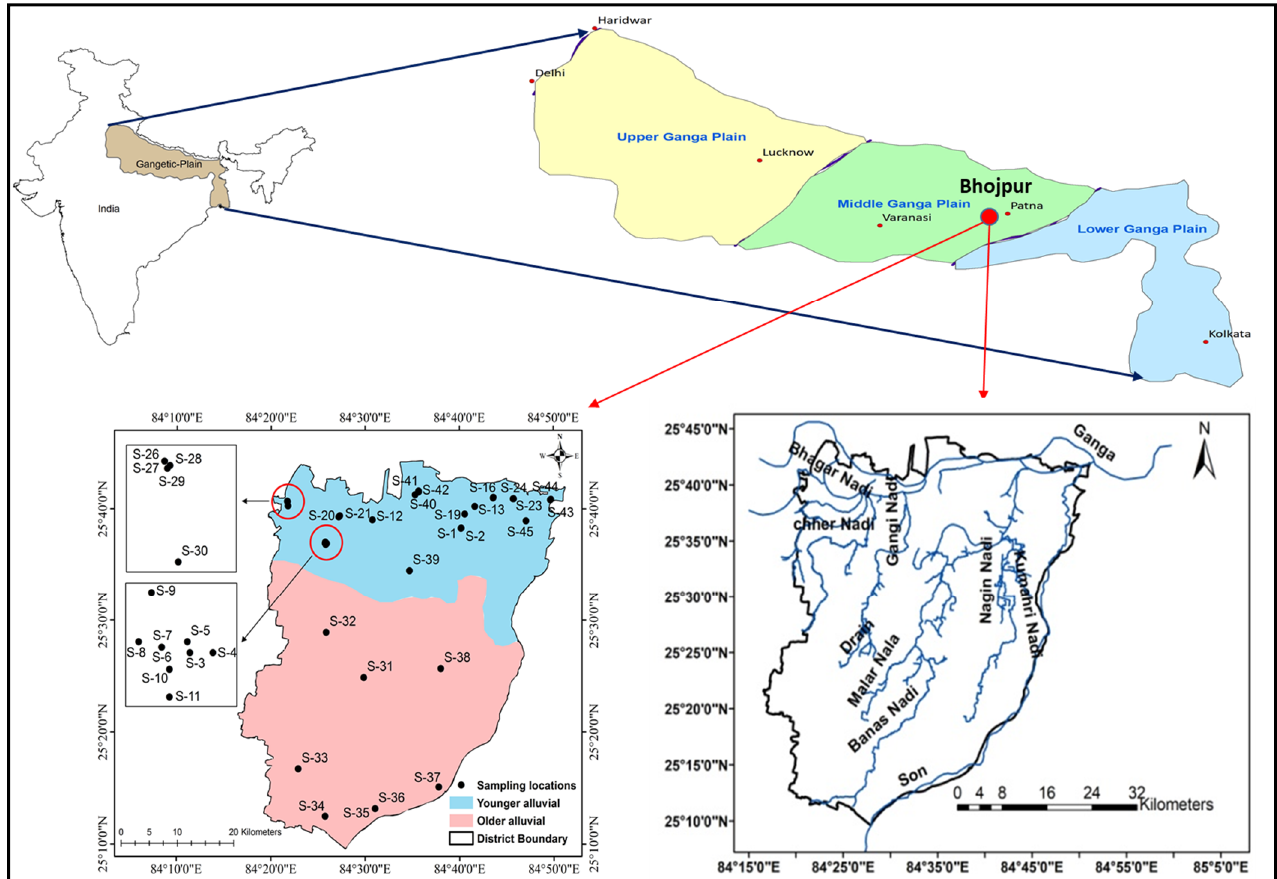
Figure 1. Study area located in central Ganga basin, drainage network, geological map with sampling locations.